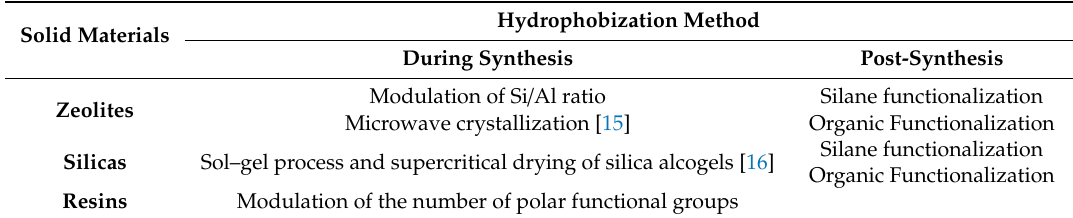
Table 2. Strategies for the synthesis of hydrophobic